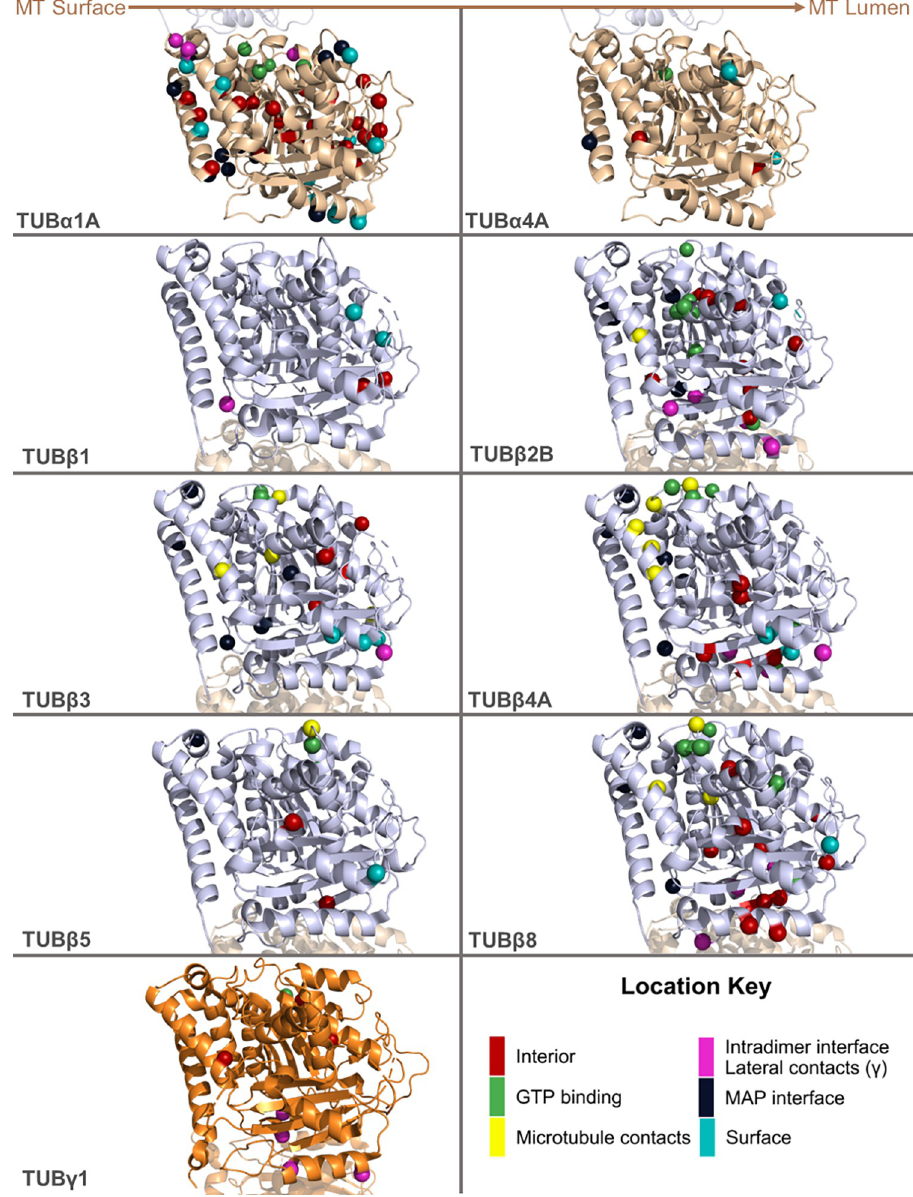
Fig 2. Visualisation of pathogenic tubulin mutations on three-dimensional structures of tubulin heterodimers. Structures of tubulin isotypes with at least five identified pathogenic mutations. Coloured residues indicate pathogenic mutations according to their location. The position of the tubulin subunit in relation to the microtubule (MT) is noted at the top. Residues in red denote mutations buried in the protein interior, while light cyan residues are on the surface. Green residues indicate mutations occurring at GTP binding interfaces, while ones in magenta highlight residues on intradimer interfaces. Navy blue and yellow residues mark mutations on residues interacting with microtubule associating proteins (MAPs) and other tubulin dimers, respectively. PDB IDs: 6s8k (for all tubulin- α and β isotypes) and 3cb2 (for TUB γ 1). Alternate versions of this figure with the structures rotated 90˚ and 180˚ around the y-axis are provided in Figs C and D in S1